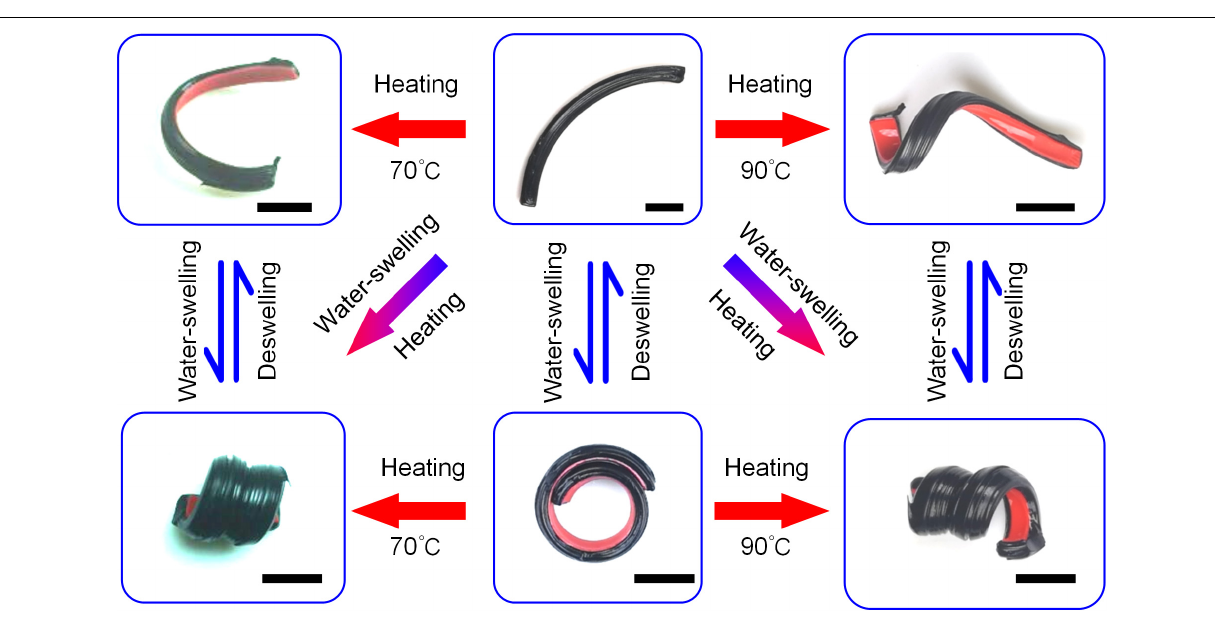
FIGURE 9 | Deformation of a PU-SMPVC bilayer structure with a quadrant shape in response to different